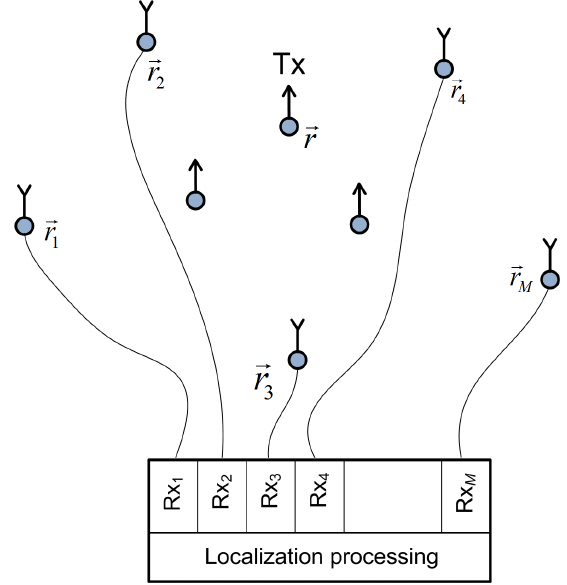
Figure 1. The topology of the studied